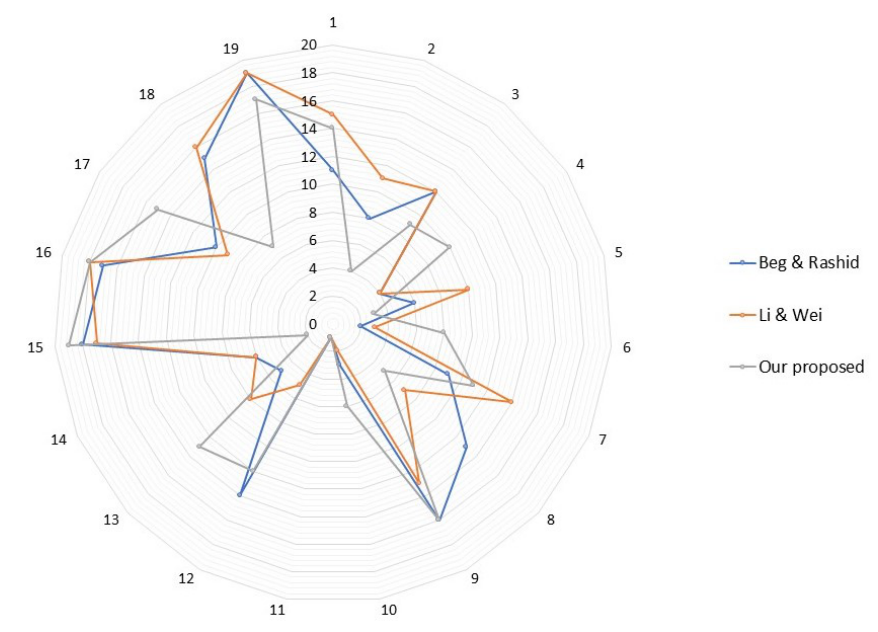
Figure 3. Sensitivity analysis using other